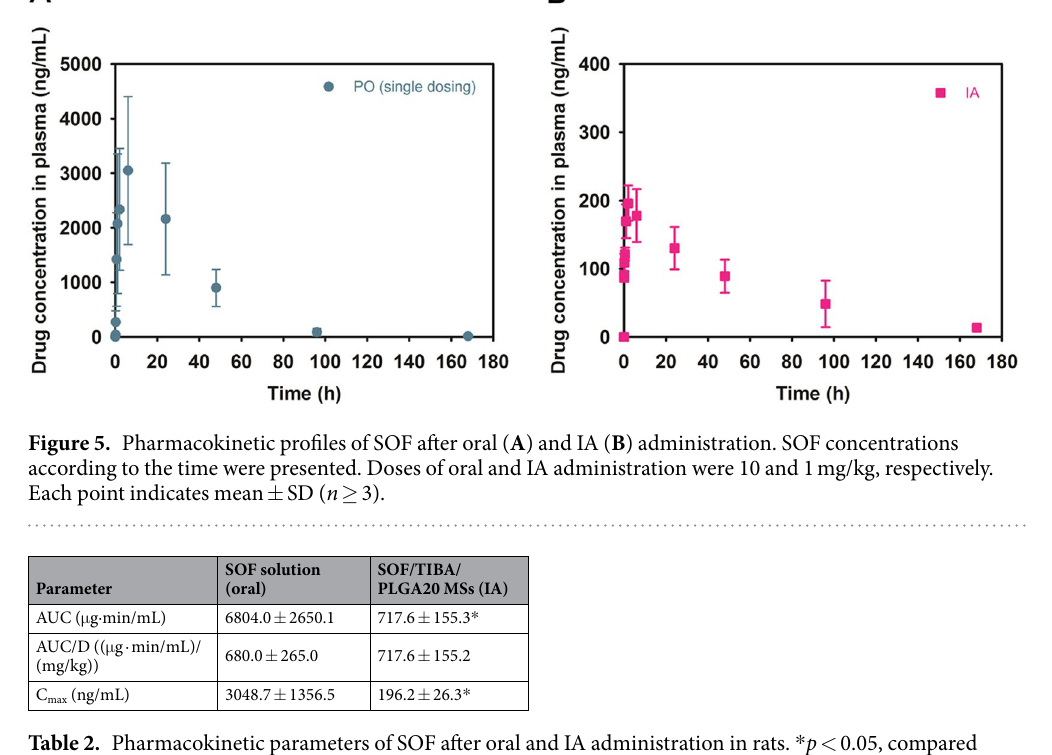
Table 2. Pharmacokinetic parameters of SOF after oral and IA administration in rats. * p < 0.05, compared with SOF solution (oral administration) group. Doses of oral and IA administration were 10 and 1 mg/kg, respectively. Data present as means ± SD ( n ≥